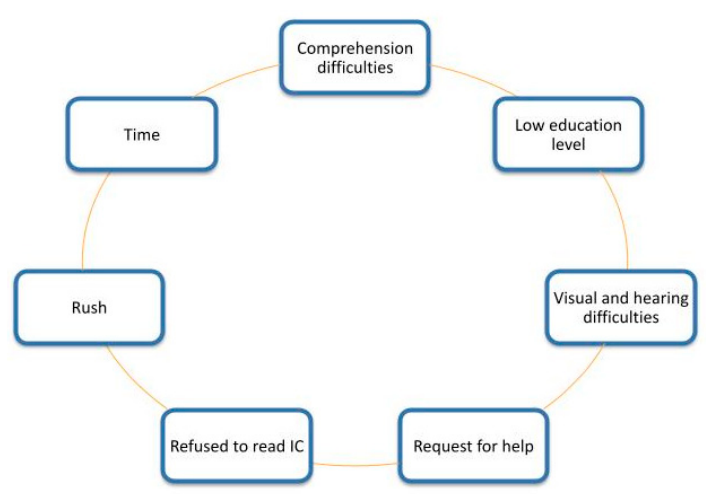
Figure 1. Topics related with informed consent in adults over 65 years.